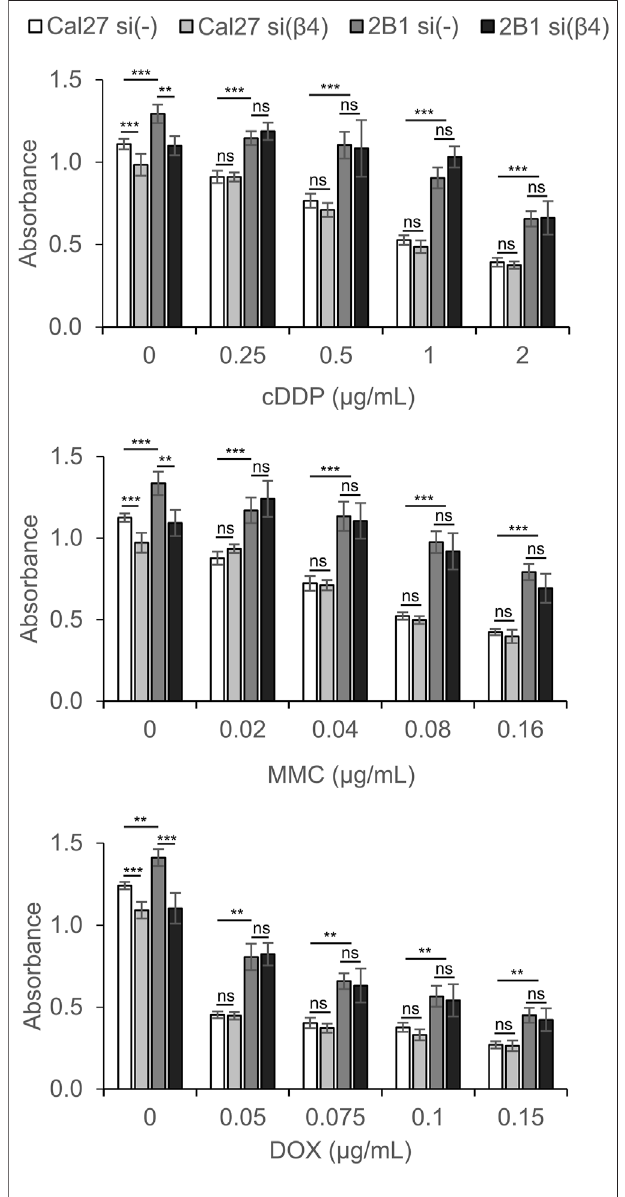
FIGURE 5 | Cal27 and 2B1 cells demonstrate decreased sensitivity to CDDP, MMC or DOX upon knockdown of integrin β 4 (si( β 4)) as compared to control Cal27 and 2B1 cells transfected with control siRNA (si(-)). Twenty-four hours upon siRNA transfection, cells were seeded in 96-well plates and 24 h later treated with different concentrations of CDDP, MMC or DOX. Cytotoxicity was measured by MTT assay 72 h later. Average absorbance data ± S.D.indicating survival,arerepresentativeofatleastthreeindependent experiments yielding similar results. Data were analyzed by two-way ANOVA with Bonferroni post-test. ns, not signi fi cant; ** p < 0.01; *** p <